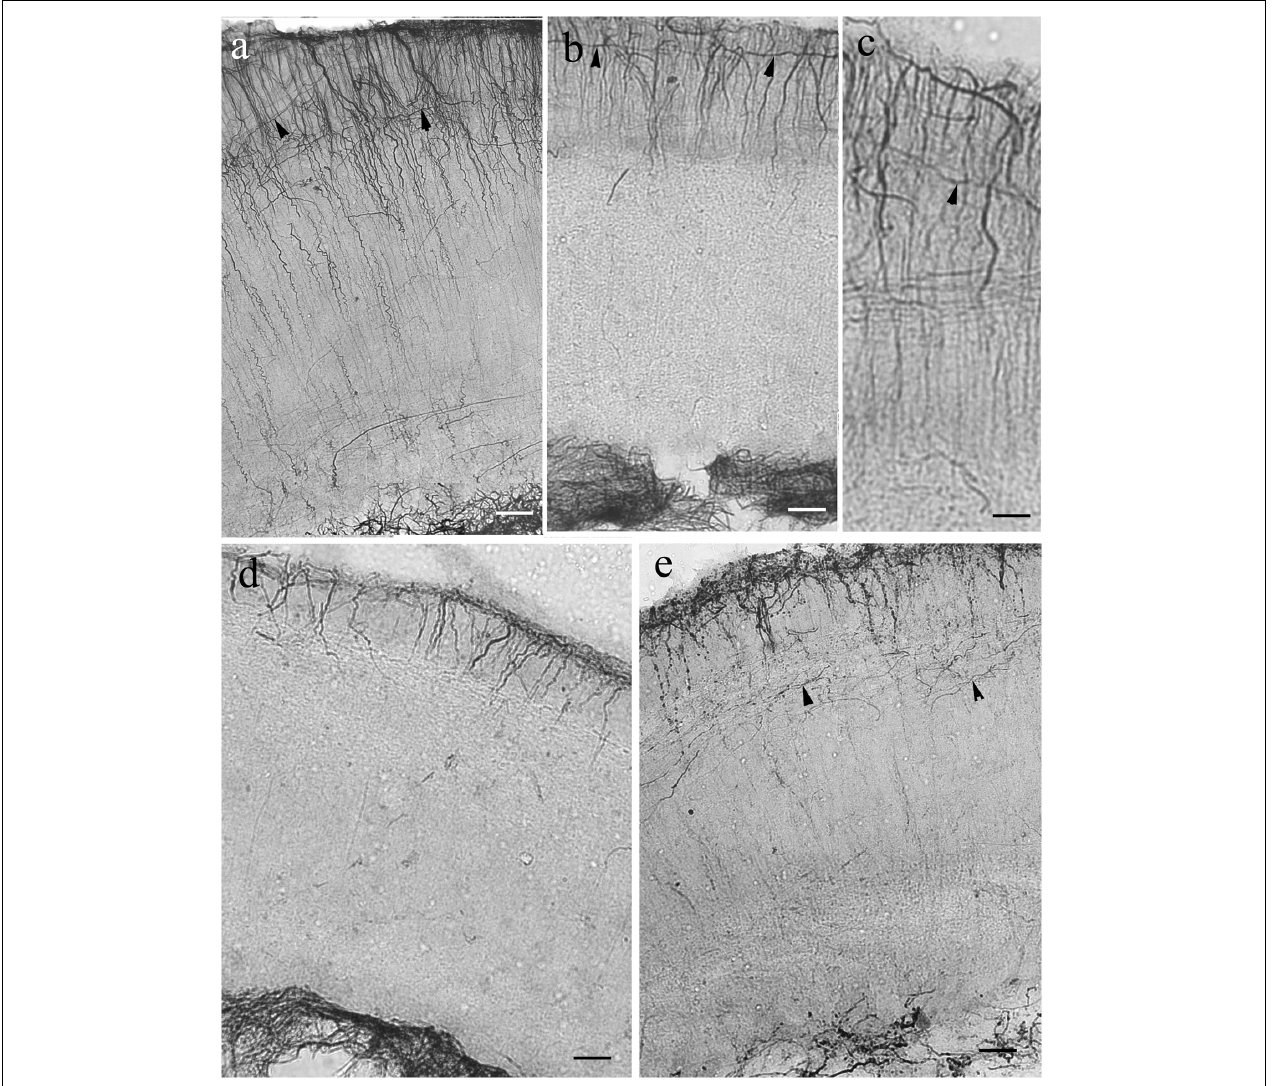
FIGURE 9 | Tectum details of Ostariophysi: processes are not immunostained in full length. The meningeal surfaces are upward. The glial processes (arrows) are visualized well only in the upper part of the section. (a) Carp. The upper zone is rich in secondary fibers, among them even horizontal ones. (arrowheads). In the deeper zone glial processes are visible only scarcely. Scale bar: 60 µ m. (b) bream. The pattern is similar to that of carp; in the deeper zone no processes are visible. Scale bar: 60 µ m. (c) Bream. The enlarged detail reveals better the rich superficial glial system. Scale bar: 20 µ m. (d) Bleak. Only the submeningeal part of glial processes is visualized. Scale bar: 60 µ m. (e) Catfish. The process system is less dense than in cyprinids. Scale bar: 60 µ